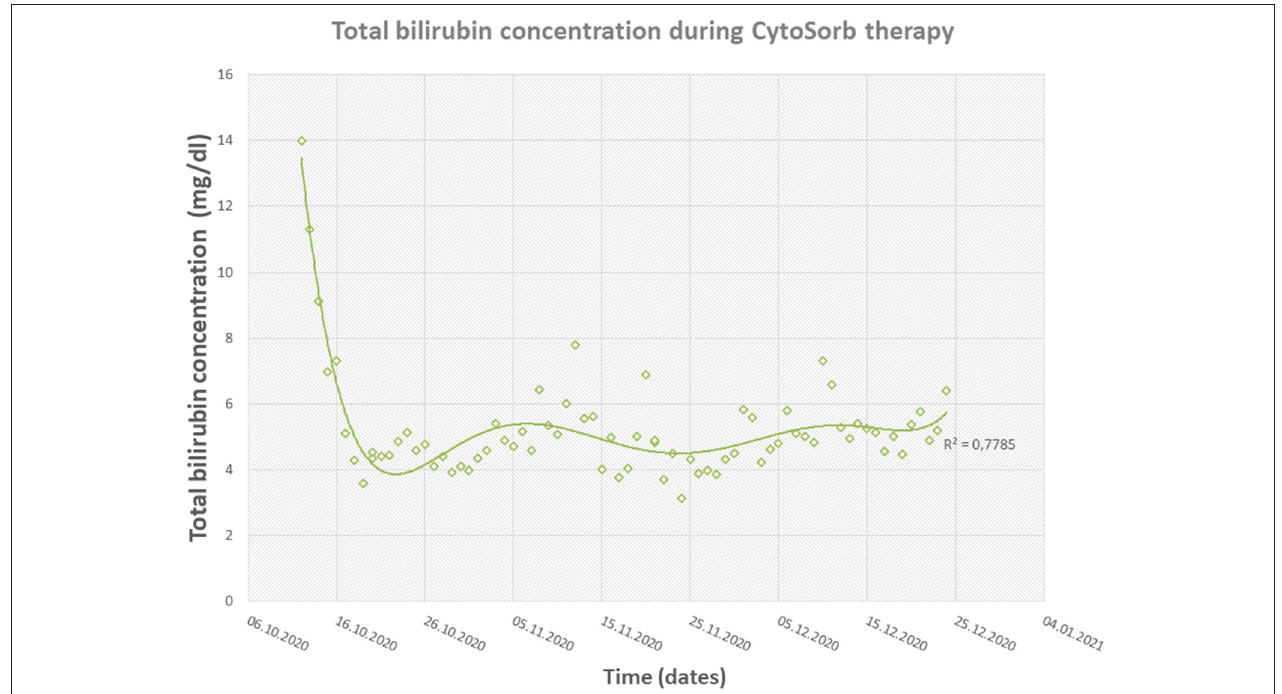
FIGURE 4 | Diagram showing the fast reduction in total bilirubin concentrations during CytoSorb therapy.